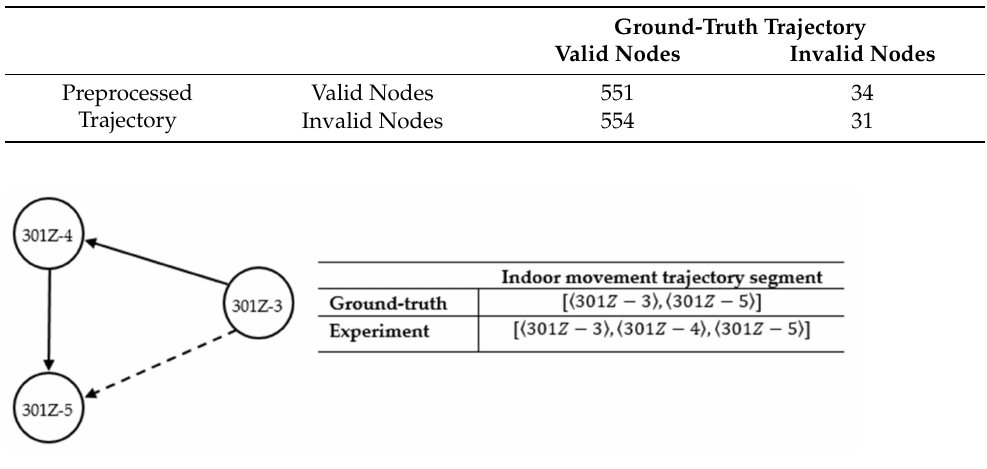
Figure 13. Representation of an existing situation in which the developed preprocessing algorithm cannot detect invalid trajectory point: dashed lines show ground-truth and solid line shows collected data from our experiment.